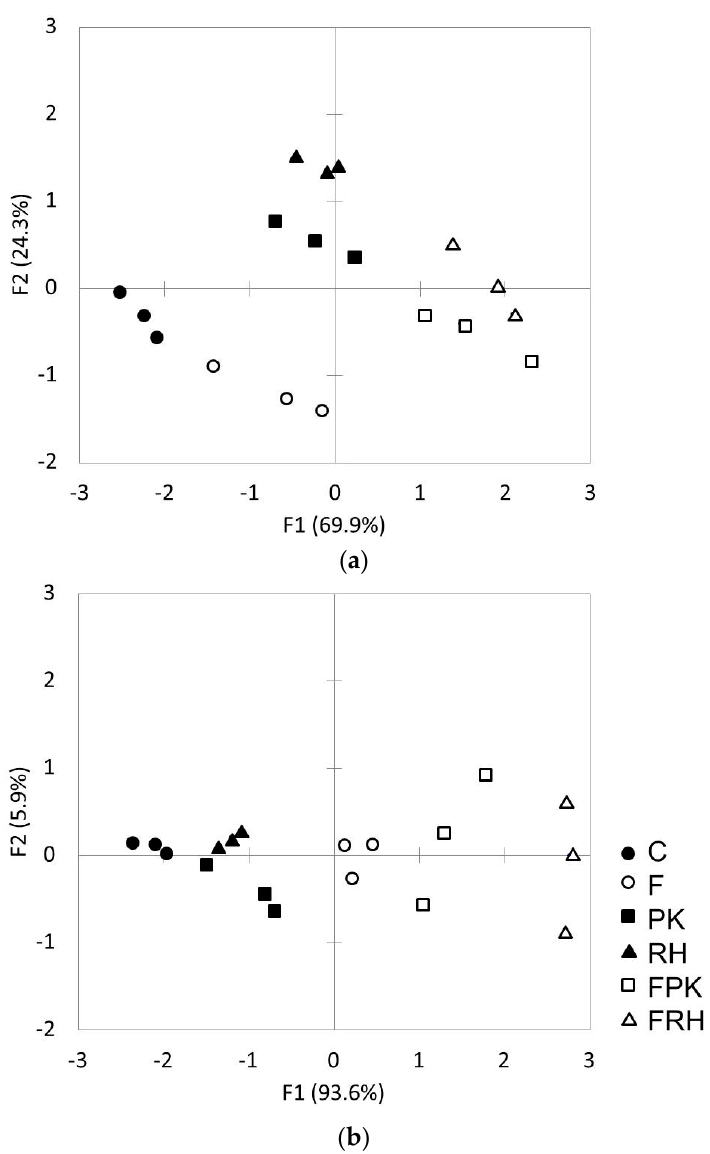
Figure 1. Principal component analysis (PCA) applied to soil microbial biomass ( a ) and Zea mays performance ( b ) after the 75 day of planting. C = control; F = fertilizer; PK = palm kernel biochar; RH = rice husk biochar; FPK = palm kernel biochar + fertilizer; FRH = rice husk biochar + fertilizer.